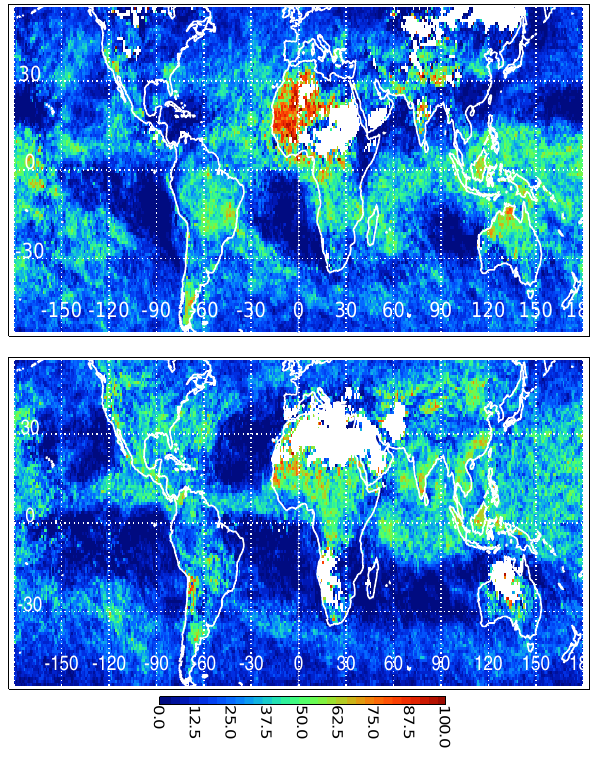
Fig. 11. Fraction of cloudy pixels designated as distinct multi-layer as derived from OMI/MODIS for January (top) and July (bottom) 2007.